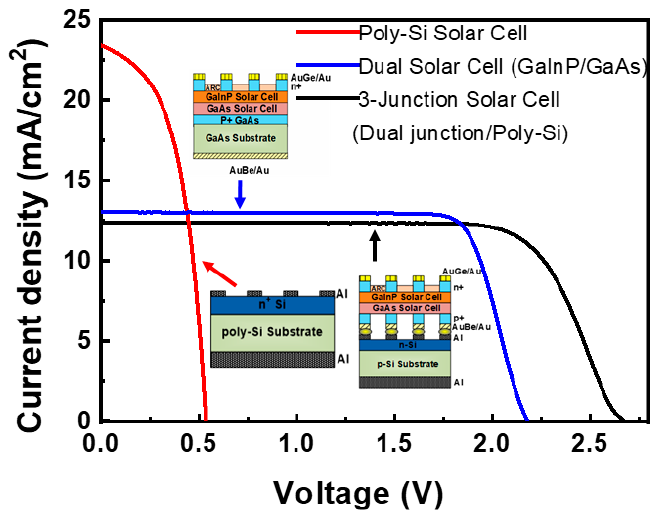
Figure 4. J–V characteristics of the GaInP/GaAs//poly-Si triple-junction solar cell measured with the one-sun AM1.5G light source. Table 2. Device characteristics of poly-Si, DJ solar cell and GaInP/GaAs/poly-Si triple-junction solar cells measured under 1 and 12 suns obtained from the J–V curve.